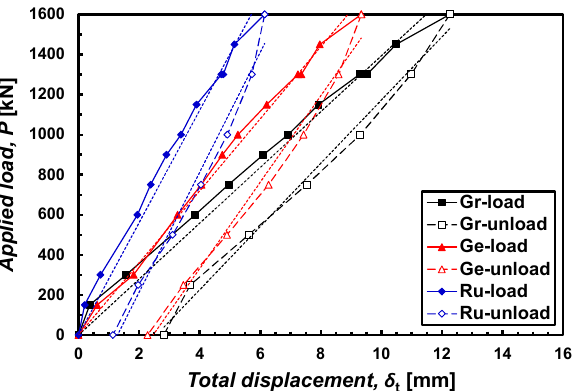
Figure 5. Comparison of pullout capacity of micropiles with different installation methods.